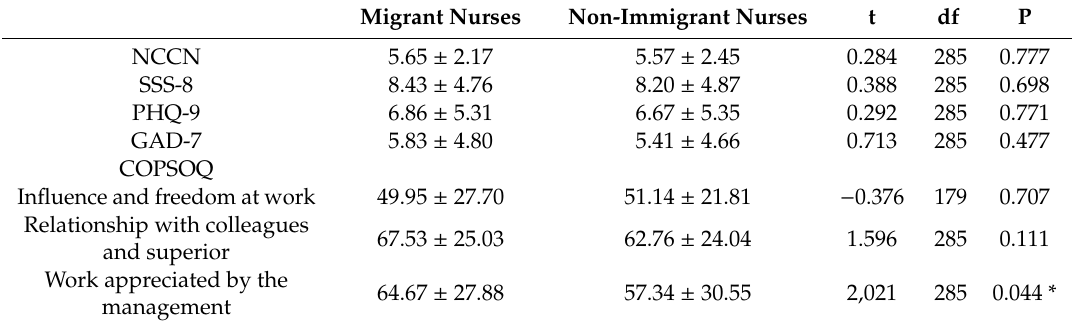
Table 2. Comparison between immigrant and non-immigrant nurses regarding mean scale